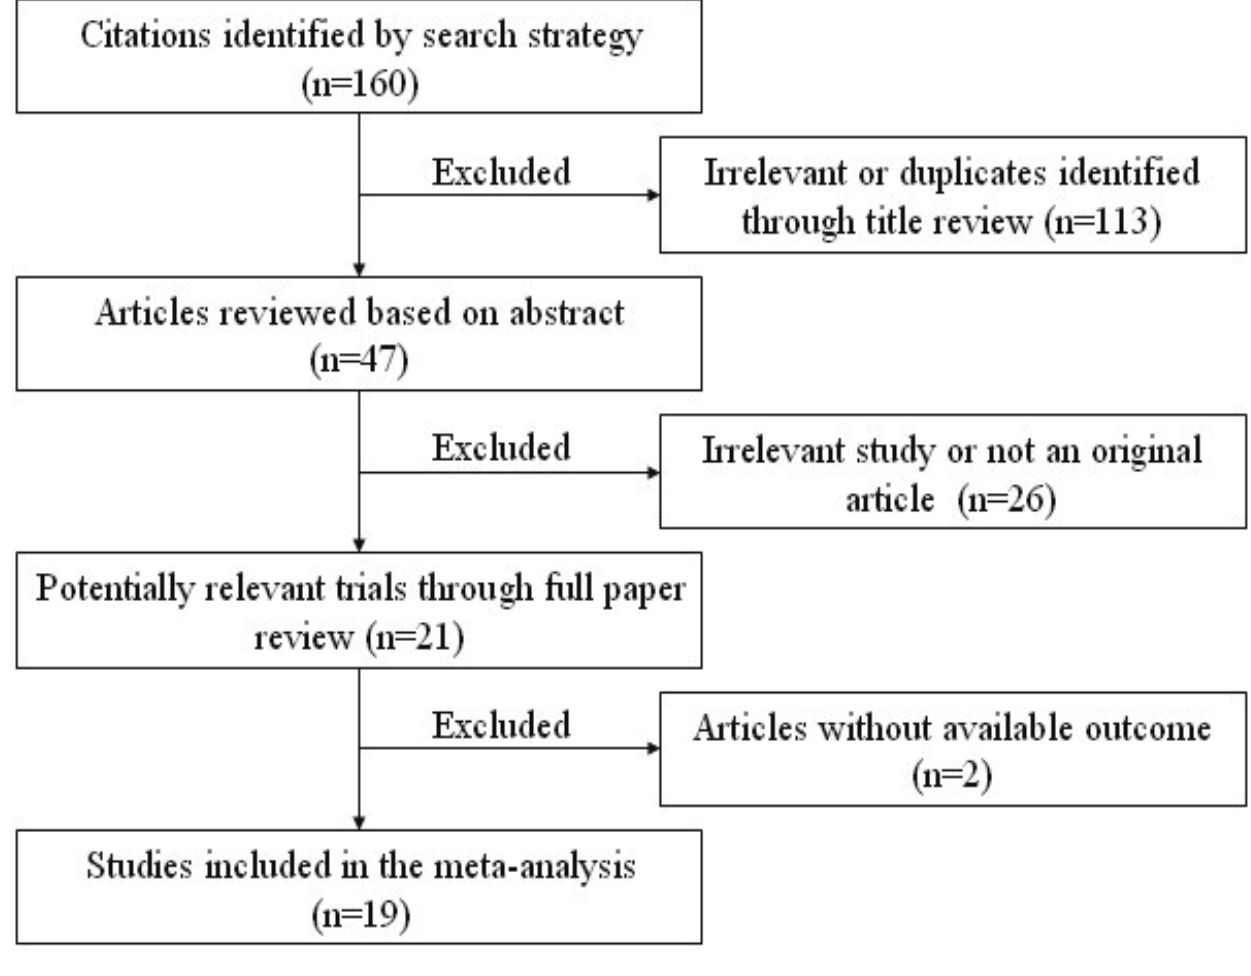
Figure 1. The flow diagram of the meta analysis.